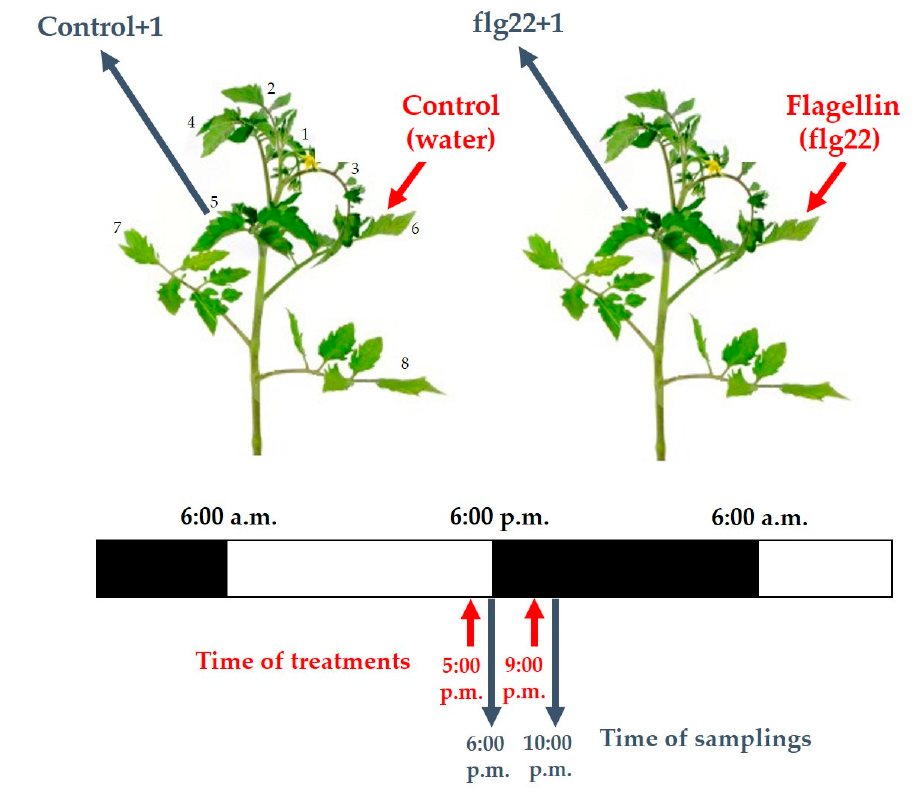
Figure 6. Experimental setup of flg22 treatments and time of samplings in intact tomato plants.